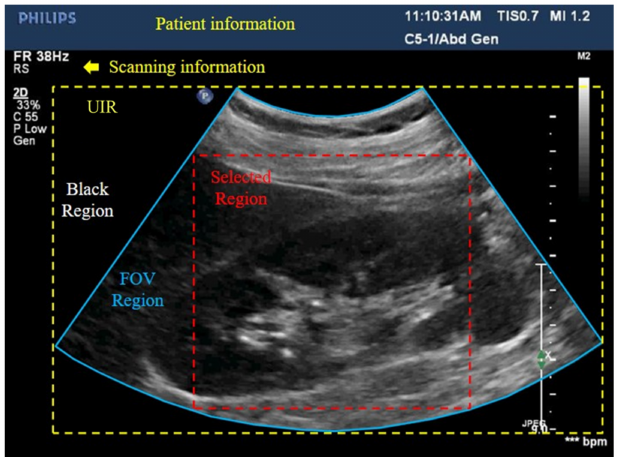
Figure 2. Digital scan-converted ultrasound image (kidney) shown on display. This ultrasound image (USI) region includes not only the field of view (FOV) region (blue box), but also the black region according to FOV and various information. To train ultrasound images, they are generally cropped to an USI region (yellow dotted rectangle) or selected region (red dotted